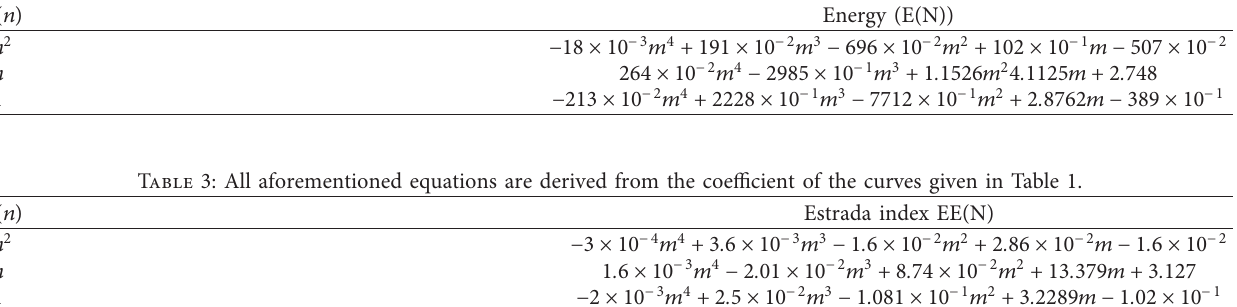
C nanosheet. 4 8